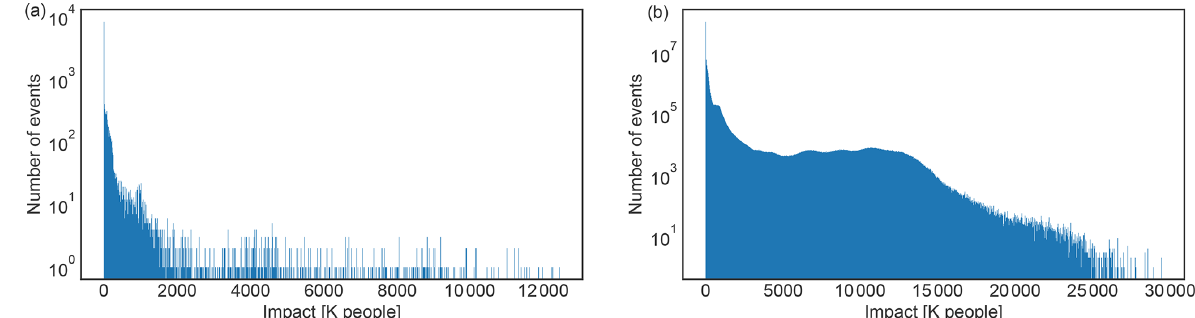
Figure D8. Histogram of the number of storm surge events in the probabilistic set by their impact (in thousands (K) of affected people) in Vietnam for present climate conditions (2020) for (a) the original case study probabilistic set, and (b) union of the probabilistic sets for all samples of input parameters considered in Sect. 3.2.4 (cf. Fig. D3). Note the logarithmic scale of the vertical